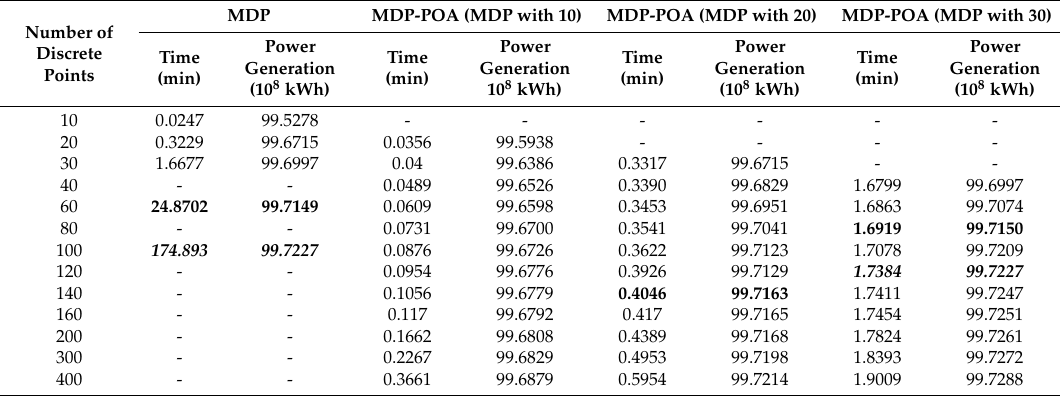
Table 4. Detailed calculation results of MDP and MDP-POA in the normal year.